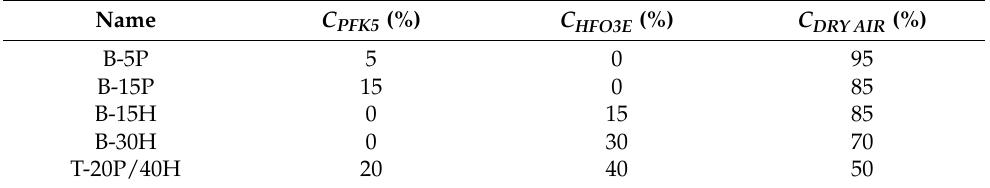
Table 7. Nomenclature and concentration ( C ) of the components of the gas mixtures used for